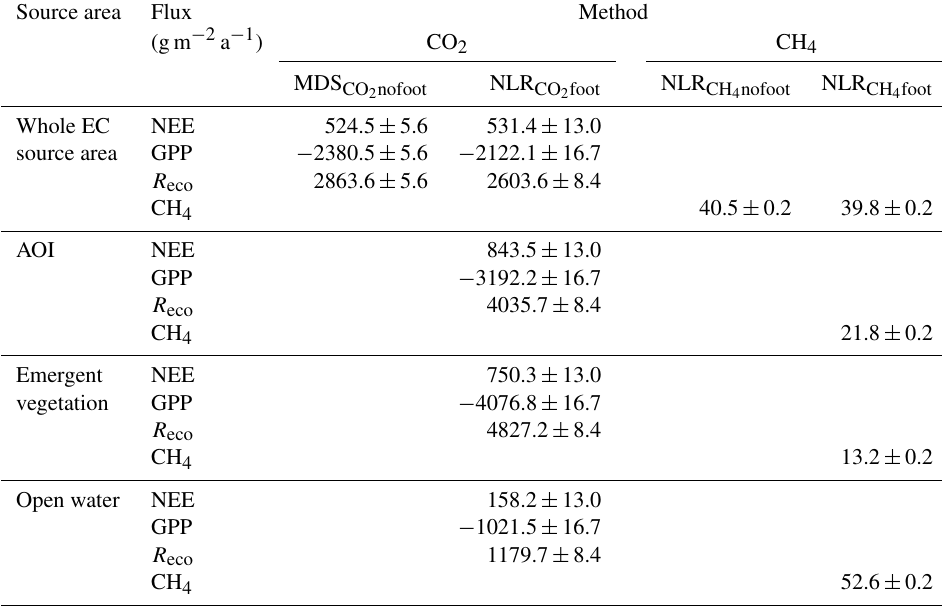
Table 3. Annual balances of CO 2 and CH 4 derived by different methods for the whole EC source area, the area of interest (AOI) and the two surface types: MDS approach without footprint consideration (MDS CO ) footprint consideration. Uncertainty was calculated as square root of the sum of squared random uncertainty (NLR CH , NLR CO 4 foot 2 foot (measurement uncertainty) and gap-filling